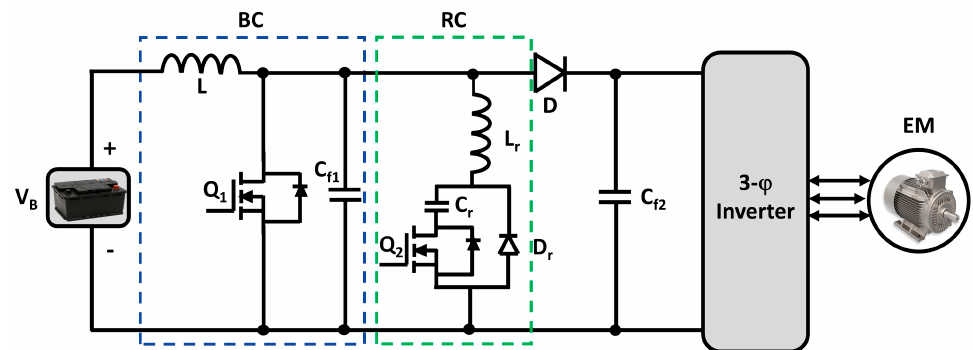
Figure 24. DC–DC Boost Converter with auxiliary Resonant Circuit.